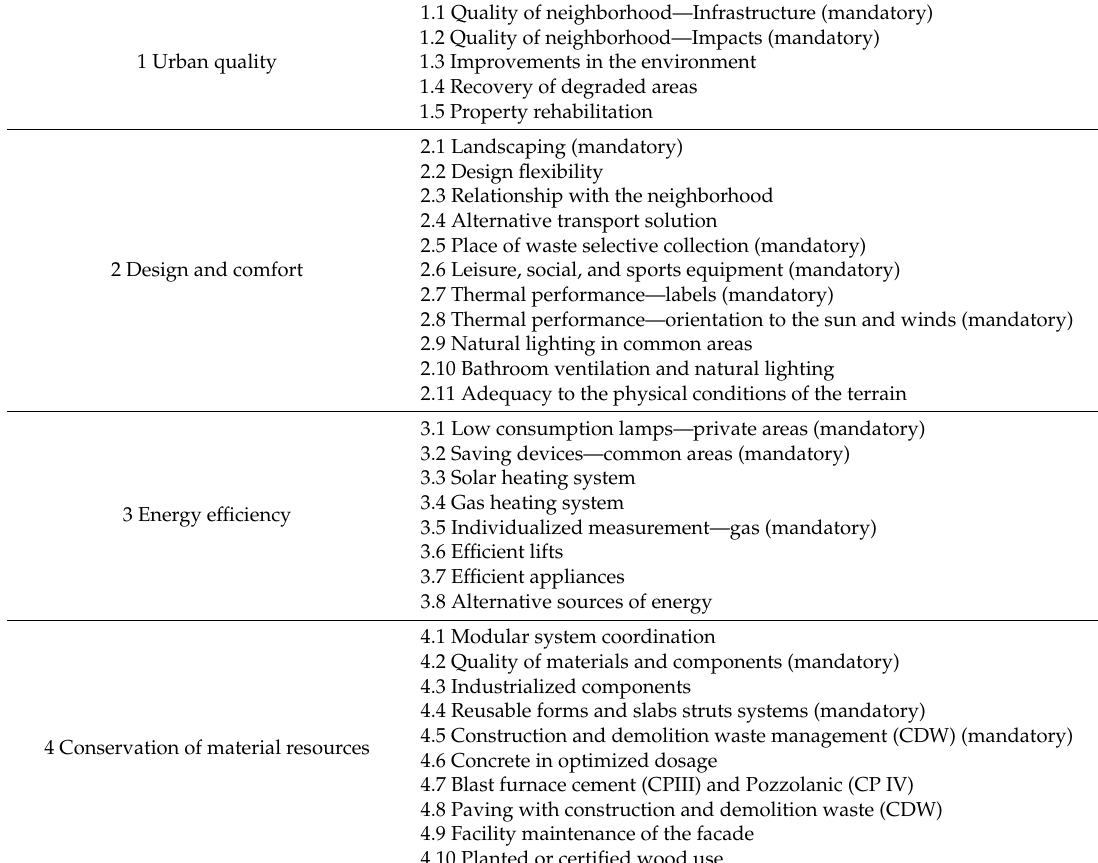
Table 4. The list of requirements established for the label evaluation